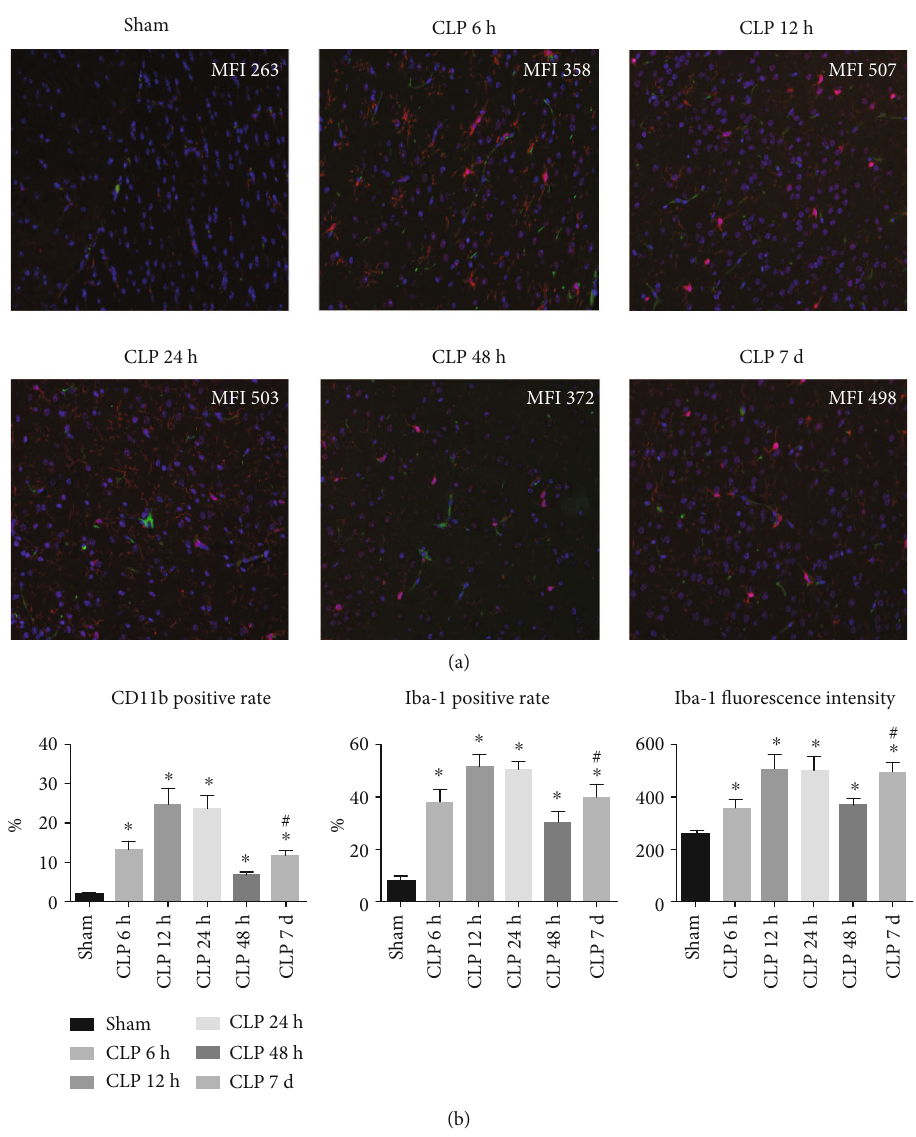
Figure 2: Microglia activation in the hippocampus region was determined by IF at 6h, 12 h, 24 h, 48 h, and day 7 post surgery. (a) Representative image of the IF assay in the hippocampus. Specimens were stained with CD11b (green), Iba-1 (red), and DAPI (blue). Representative images were merged and analyzed (1: 200). Mean fl uorescence intensity (MFI) of Iba-1 was shown in each image. (b) Summary data of CD11b and Iba-1 expression in the hippocampus region ( n = 5 ‐ 6 ). ∗ P < 0 : 05 vs. sham control; # P < 0 : 05 CLP day 7 vs. CLP 48